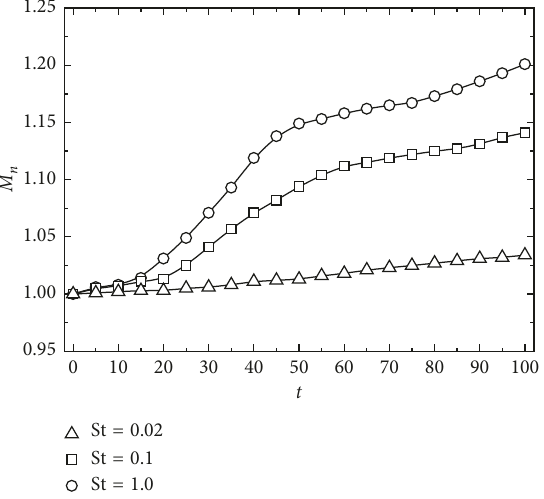
Figure 5: Change of inhomogeneous degree with time at different St (Re � 200 and a � 15).